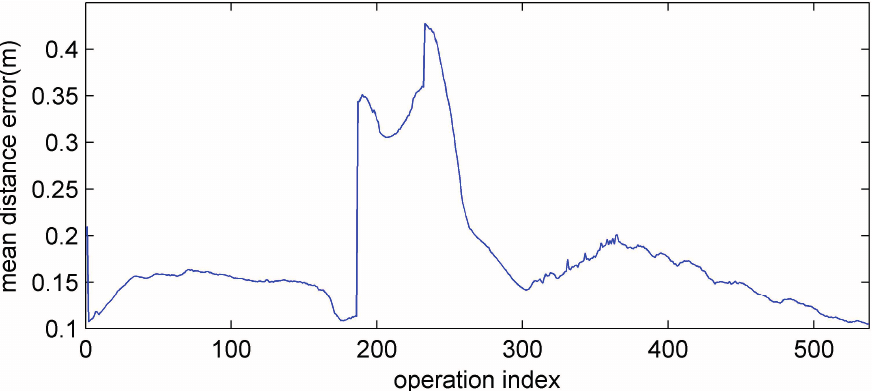
Figure 16. The mean distance error of the robots.